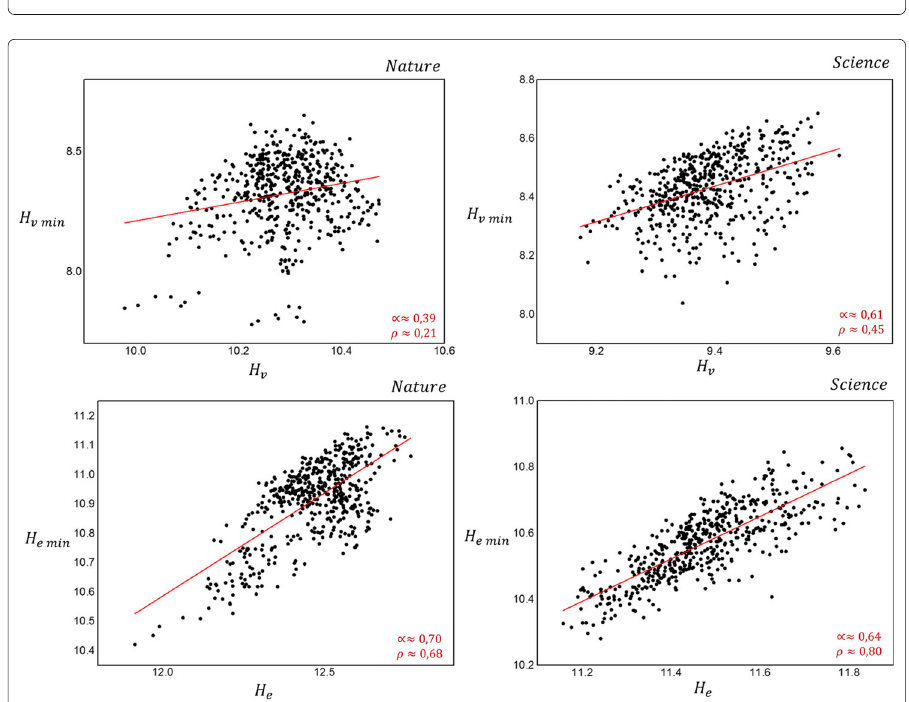
Fig. 8 Minimum entropy values, as a function of the real values H v and H e for the journals Nature and Science. The line shows the linear adjustment for the points and shows the difference between the correlation of the vertex entropies and that of the edge entropies, α is the linear fit coefficient and ρ is Pearson’s correlation